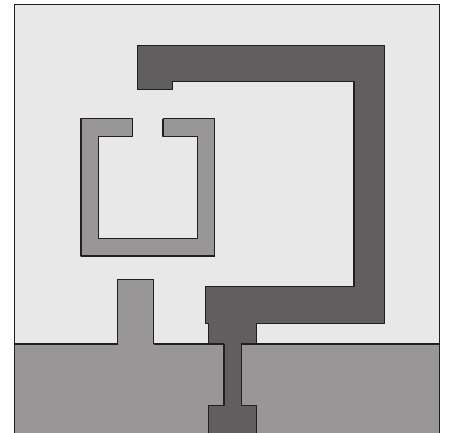
Figure 17: A C-shaped circularly polarized monopole antenna [38]. Dark gray upper metal face, medium gray bottom metal face, and light gray dielectric substrate.